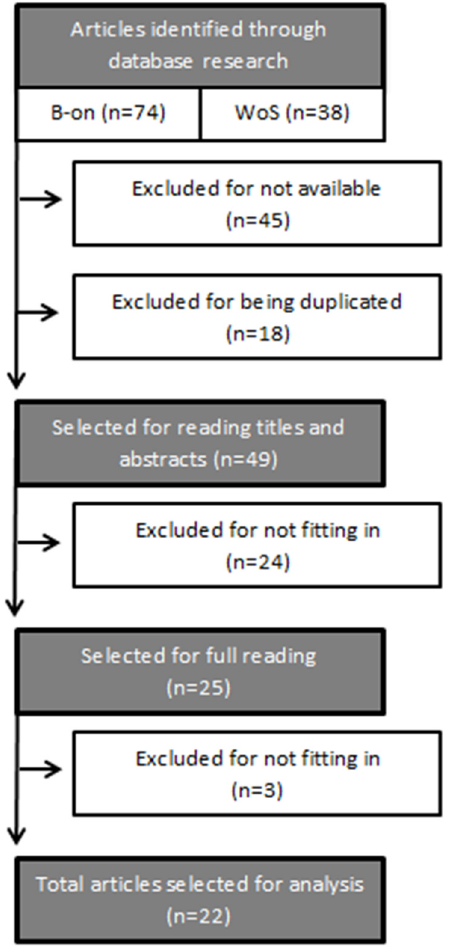
Figure 1. Flowchart of the study selection process.